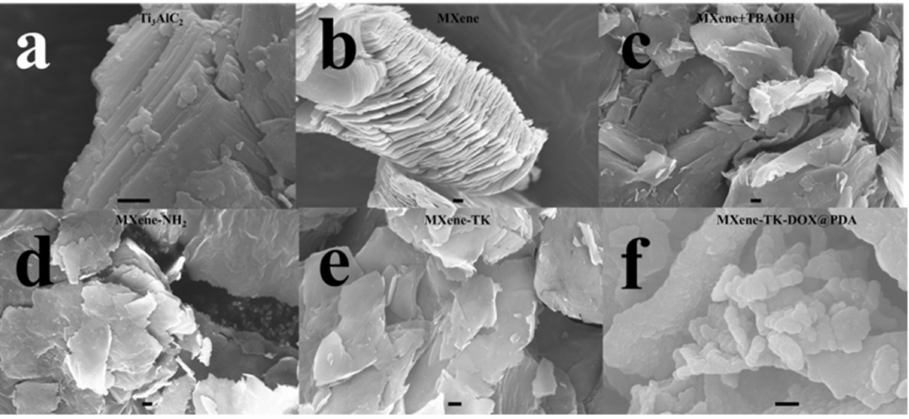
Figure 3. FE-SEM images of the ( a ) Ti 3 AlC 2 , ( b ) MXene (Ti 3 C 2 ), ( c ) MXene + TBAOH, ( d ) MXene − NH 2 , ( e ) MXene − TK, and ( f ) MXene − TK − DOX@PDA nanoparticles. Scale bars: 300